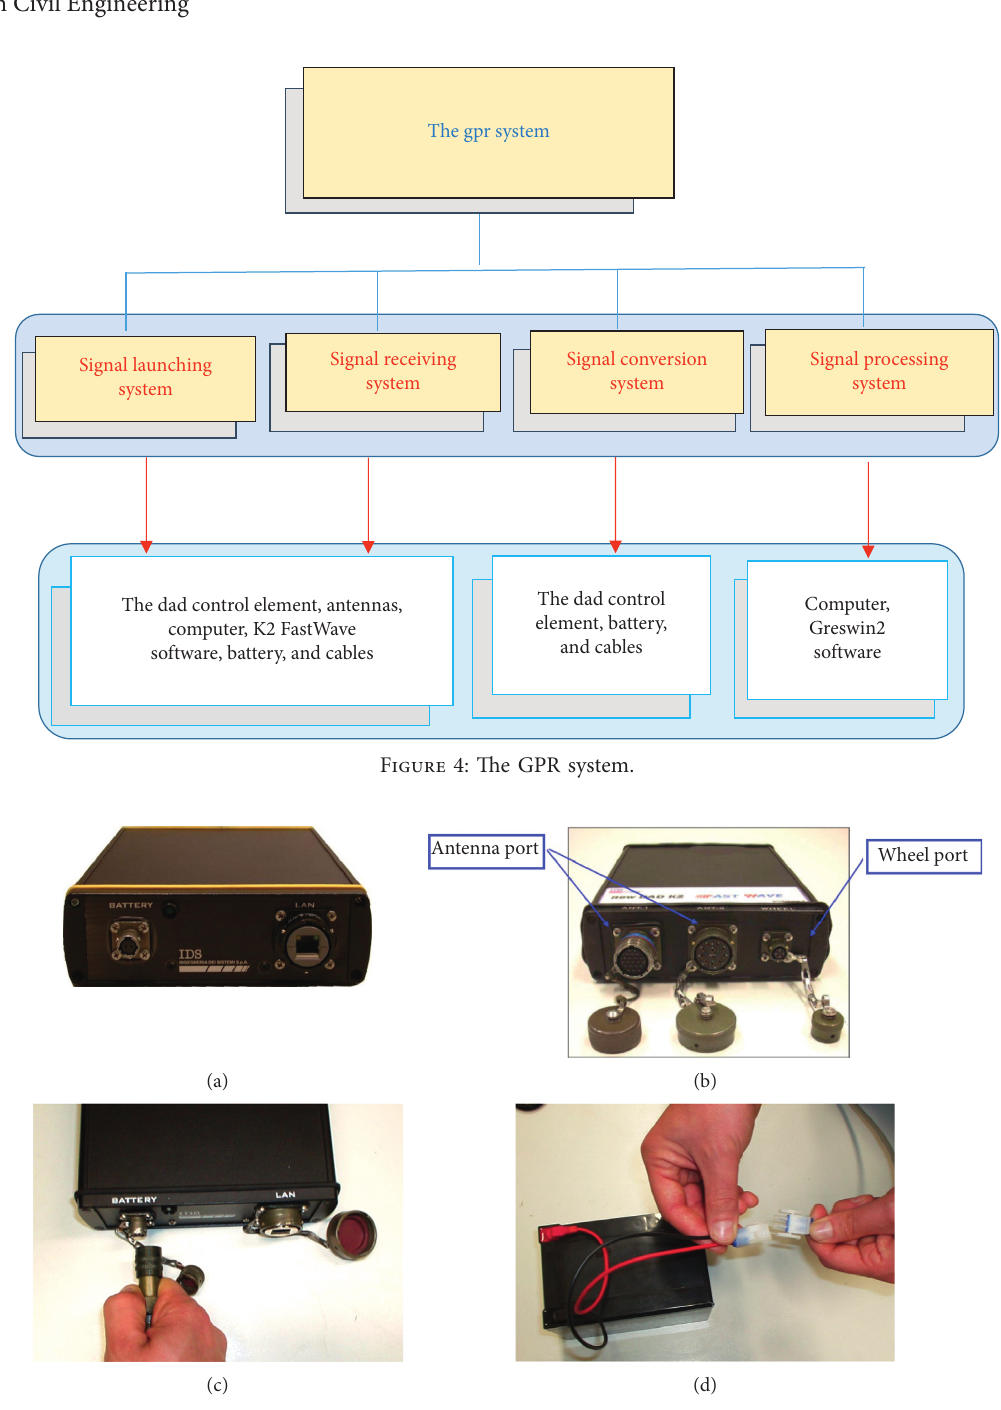
Figure 5: The DAD control element and connections. (a) Battery and LAN port on the one side of the DAD control element, (b) antenna port and wheel port on the other side of the DAD control element, (c) battery cable connected to the battery port, and (d) connection of the power energy of a sealed lead acid